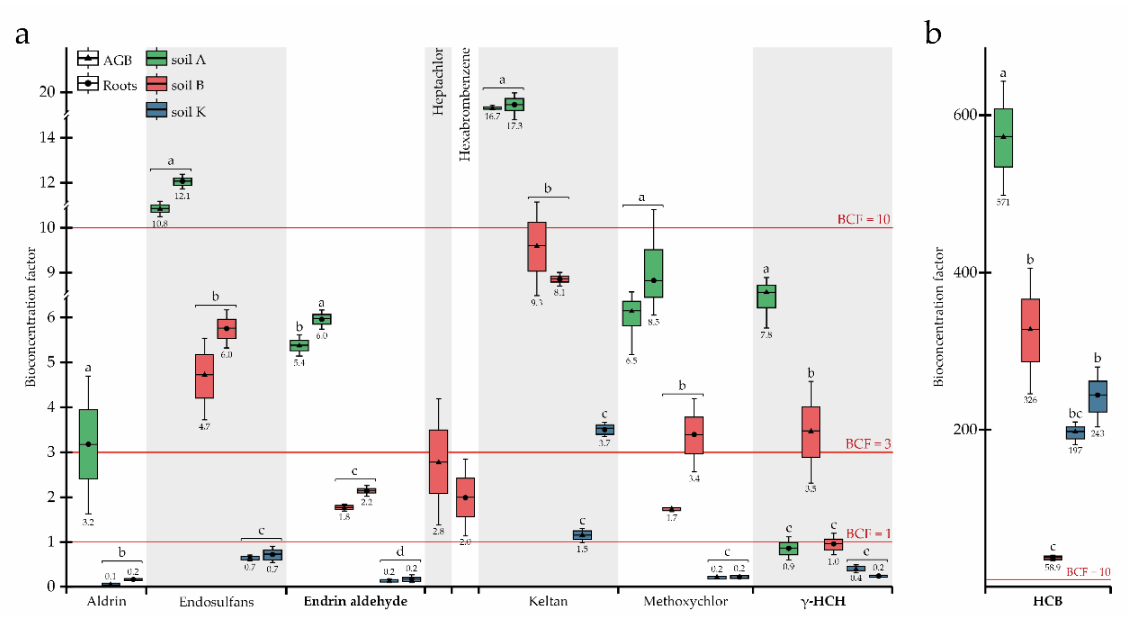
Figure 1. Bioconcentration factors for OCPs: ( a ) BCF s < 20; ( b ) BCF s > 50. OCPs highlighted in bold indicate a significant difference between BCF s due to soil origin and plant part effects. Different letters on the boxplots within one compound indicate a significant difference at p < 0.05.